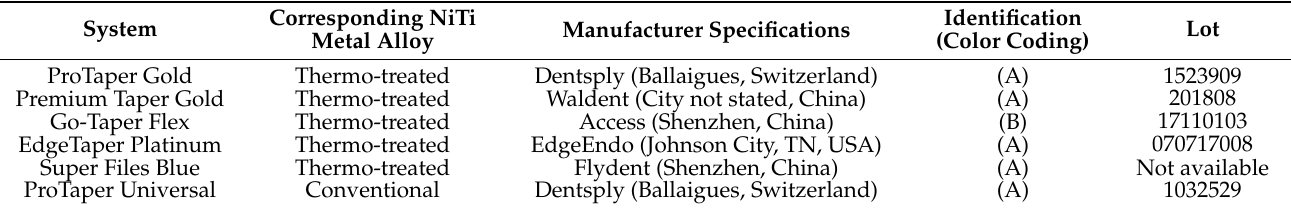
Table 1. Characteristics of the six tested rotary NiTi systems. Corresponding NiTi Identification System Lot Manufacturer Specifications Metal Alloy (Color Coding) ProTaper Gold Thermo-treated Dentsply (Ballaigues, Switzerland) (A) 1523909 Premium Taper Gold Thermo-treated Waldent (City not stated, China) (A) 201808 Go-Taper Flex Thermo-treated Access (Shenzhen, China) Thermo-treated Thermo-treated Not available ProTaper Universal